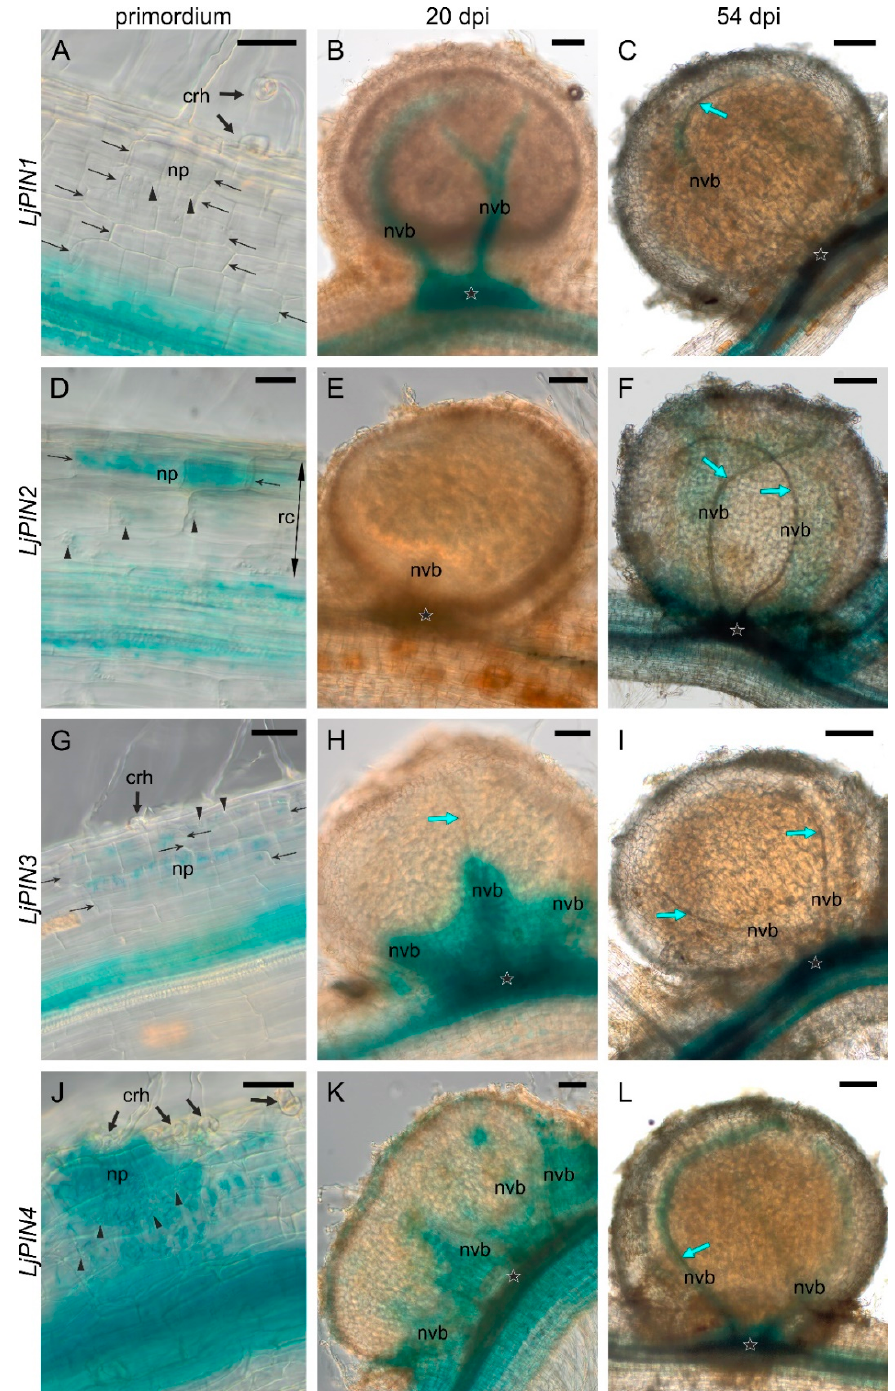
Figure 3. Expression patterns of LjPIN1 , LjPIN2 , LjPIN3 , and LjPIN4 in nodule primordium ( A , D , G and J —respectively), 20 dpi nodule ( B , E , H and K —respectively) and mature, 54 dpi nodule ( C , F , I and L —respectively), obtained by GUS histochemical assays performed on transgenic roots. np—nodule primordium; rc—root cortex; crh—curled root hair; nvb—nodule’s vascular bundle; black thin arrows—cells of root cortex in the division; arrowheads—starch grains; blue arrows—tracheal elements; stars—vascular connection between root’s stele and nodule. Bars: 20 µ m ( D ), 50 µ m ( A , G , J ), 100 µ m ( B , E , H , K ), 200 µ m ( C , F , I , L